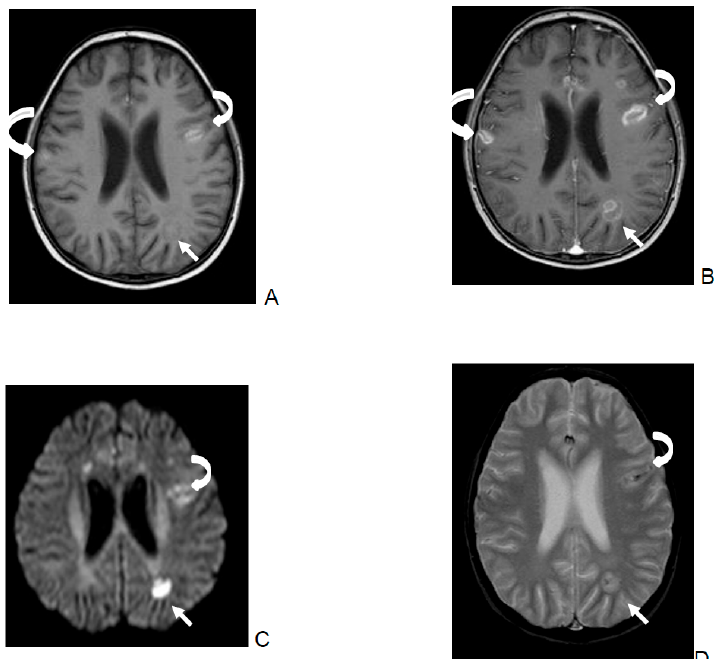
Figure 1. Multiple foci of hemorrhage with cerebritis and abscess formation in a 10-year-old boy with acute lymphoblastic leukemia. The patient died due to the fungal infection. The figure demonstrates the di ffi culties in di ff erentiating between abscesses and parenchymal bleeding (curved arrows). 1. T1-W without contrast ( A ) reveals multiple hyperintense foci of hemorrhage (curved arrows) with gadolinium enhancement of magnetic resonance imaging (MRI) lesions on T1-W image after contrast ( B ). Enhancement in areas of parenchymal bleeding may have di ff erent patterns, such as ring, focal, and di ff use–patchy. Because of the hemorrhagic nature of the lesions, a hypointense rim or foci are usually present in SWI or GRE T2* ( D ). Factors such as oxyhemoglobin in the hyperacute stage or extracellular methemoglobin in the late sub-acute stage a ff ect how the DWI ( C ) signal appears in the presence of hemorrhage. These substances are thought to give parenchymal hemorrhage the hyperintense appearance on DWI (curved arrow, C ) and low ADC values, which is similar, but usually not as strong as the restricted di ff usion seen in an abscess (straight arrow, C ). 2. The abscess (white straight arrow) shows a small hyperintensity in T1-W without contrast (A), clear restricted di ff usion within the core of the lesion (straight arrow, C ) with a ring like enhancing lesion ( B ) and hypointense foci in GRE T2* ( D ). Brain abscesses due to a fungus are usually hypointense on the T1-W image before contrast, but show small areas of hyperintensity due to the presence of iron, manganese, or methemoglobin ( A